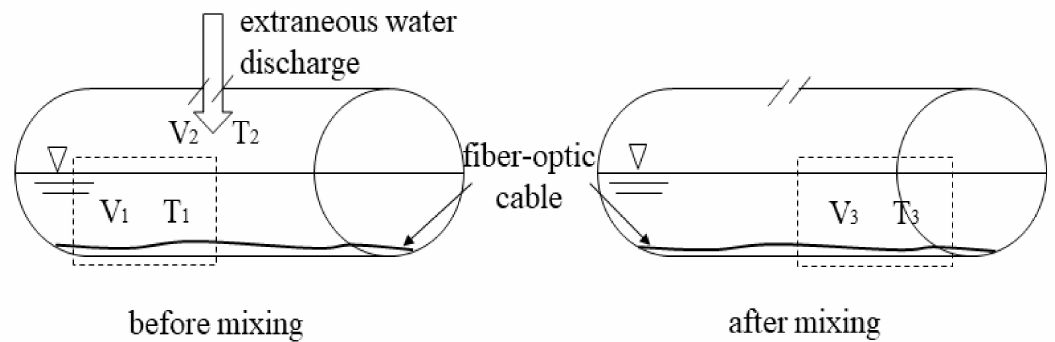
Figure 2. Extraneous water I/I with volume V 2 and temperature T 2 into the separate sewer network with volume V 1 and temperature T 1 resulting in a mixed flow with a new volume V 3 and temperature T 3